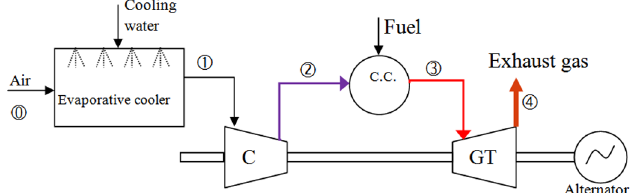
Fig. 1. A schematic diagram of the